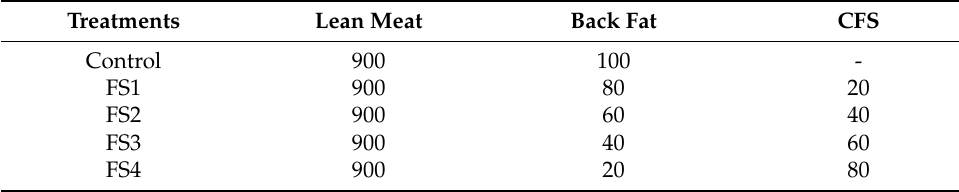
Table 1. Formulation (g/kg) of Harbin dry fermented sausages.